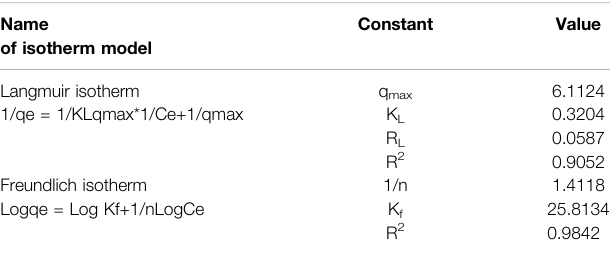
TABLE 3 | Adsorption constants derived from simulations with different isotherm models.